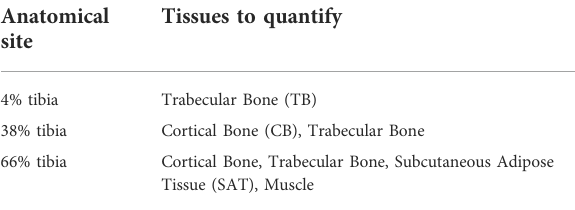
TABLE 1 Tissues to quantify in each anatomical